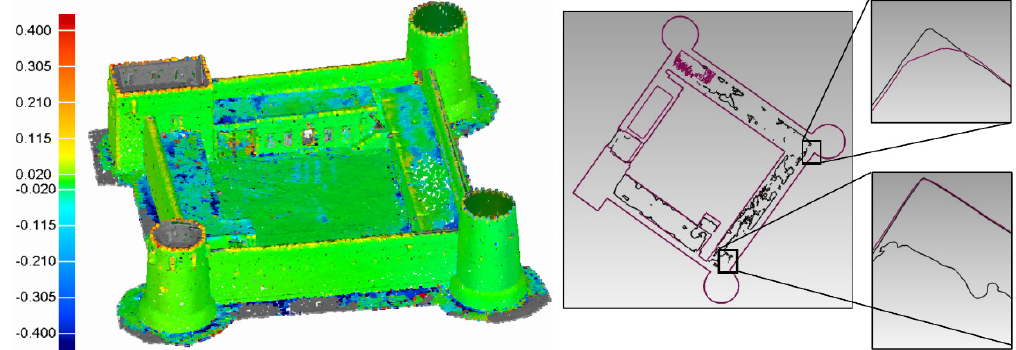
Figure 14: Agisoft PhotoScan - 3D comparison to reference (left) generated in Geomagic (green = ±2cm) and comparison of horizontal sections (black = image-based, red = laser scanning data) with maximum difference of 2cm